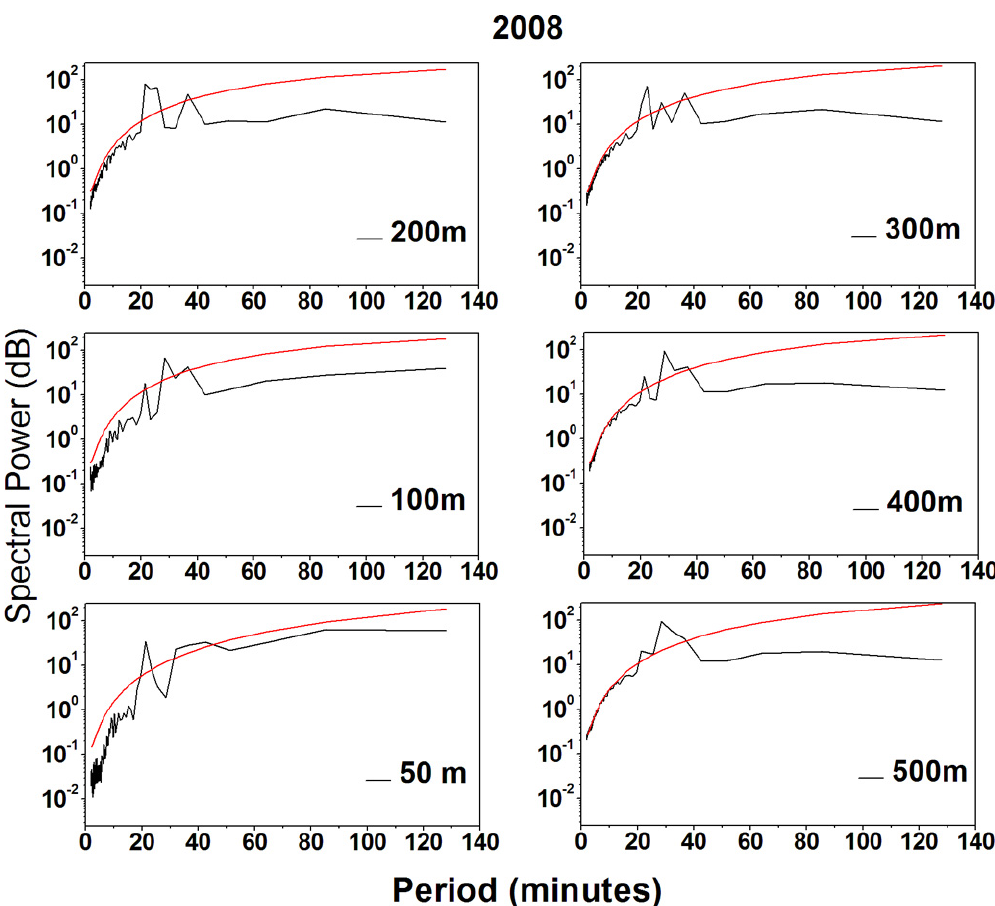
Fig. 6. Composite spectral power for aerosol backscatter signal at 50m, 100m, 200m, 300m, 400m and 500m, for all the experimental days in